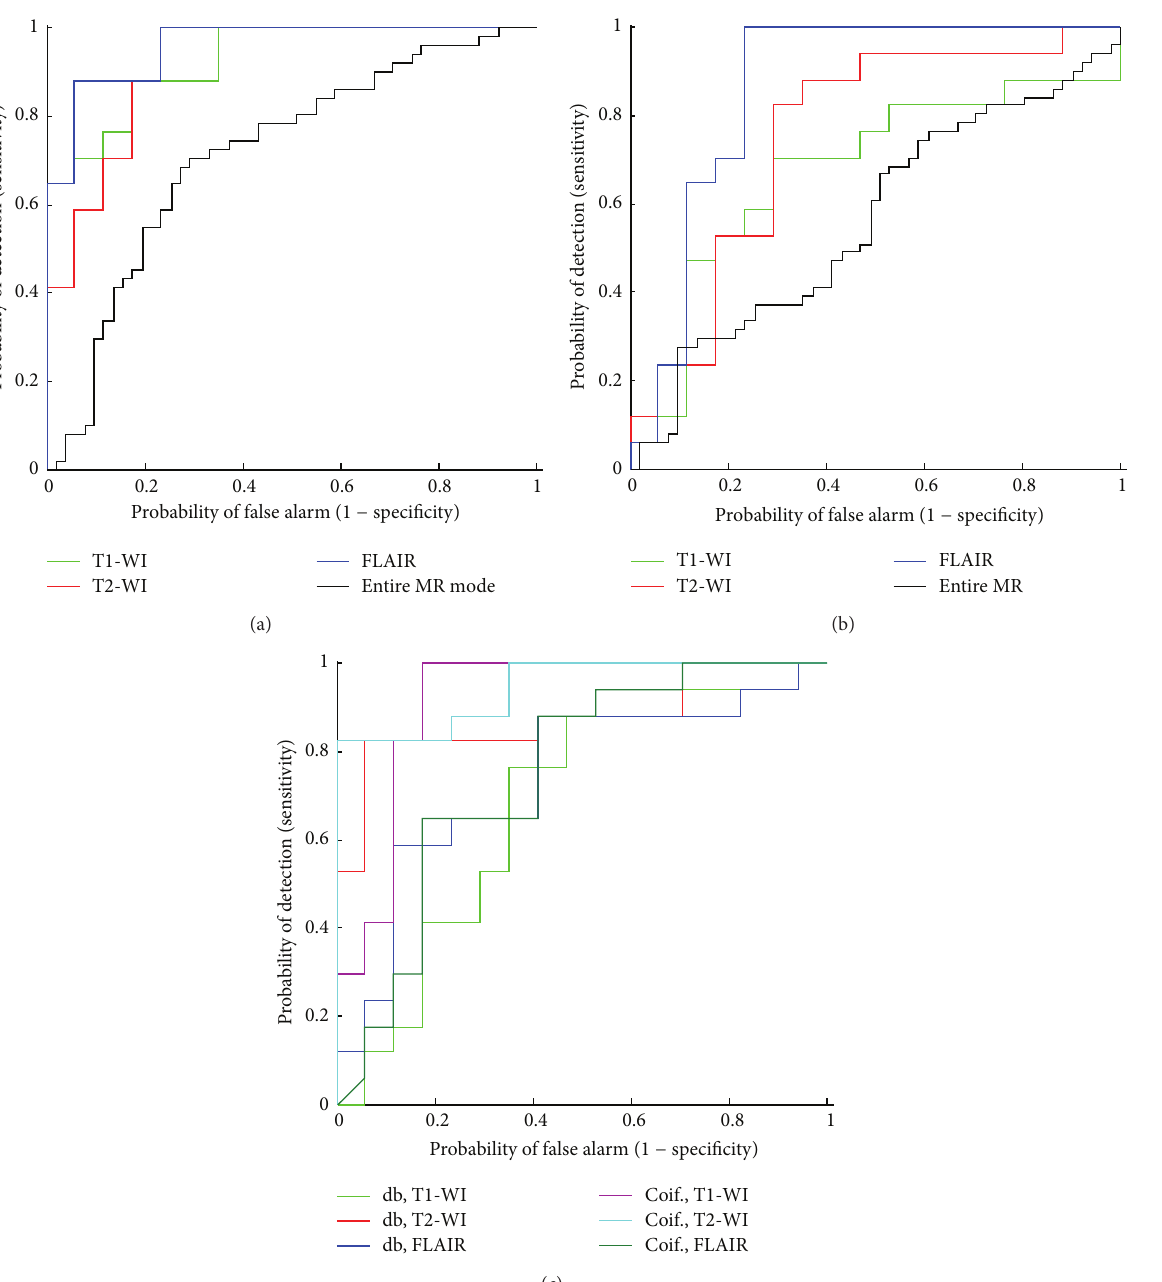
Figure 7: ROC curves of GBM and normal area discrimination based on T1-WI, T2-WI, FLAIR, and entire MR mode (T1-WI, T2-WI, and FLAIR, 51 images): (a) GMM features, (b) PCA features, and (c) Daubechies ( db1 ) and Coiflets ( coif1 ) wavelet